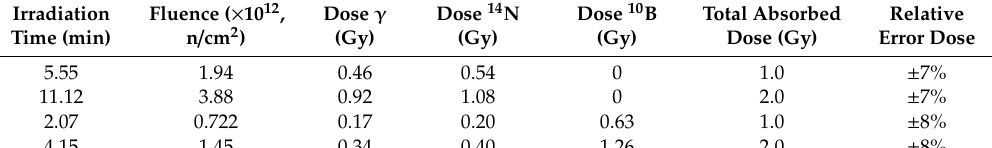
Table 2. Dosimetry for thermal neutron irradiation without and with boron (10 ppm 10 B).